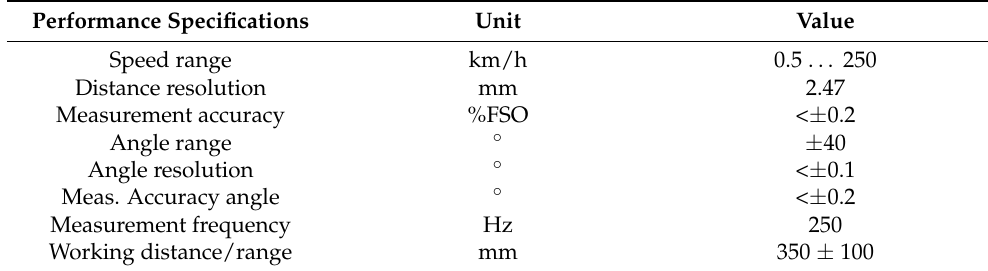
Table 3. The Correvit S-350 Aqua sensor enables accurate recording of dynamic manoeuvres of different vehicles and on different surfaces [47]. Table 3. Basic technical data of the Correvit S-350 Aqua optoelectrical sensor [47].